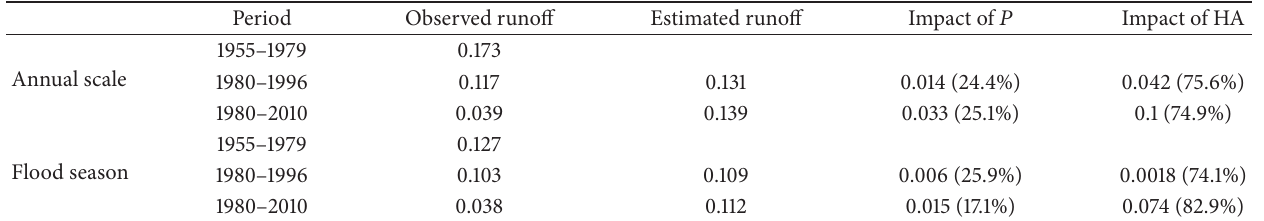
Table 3: Impacts of precipitation ( 𝑃 ) and human activities (HA) on changes of runoff (10 9 m 3 ).